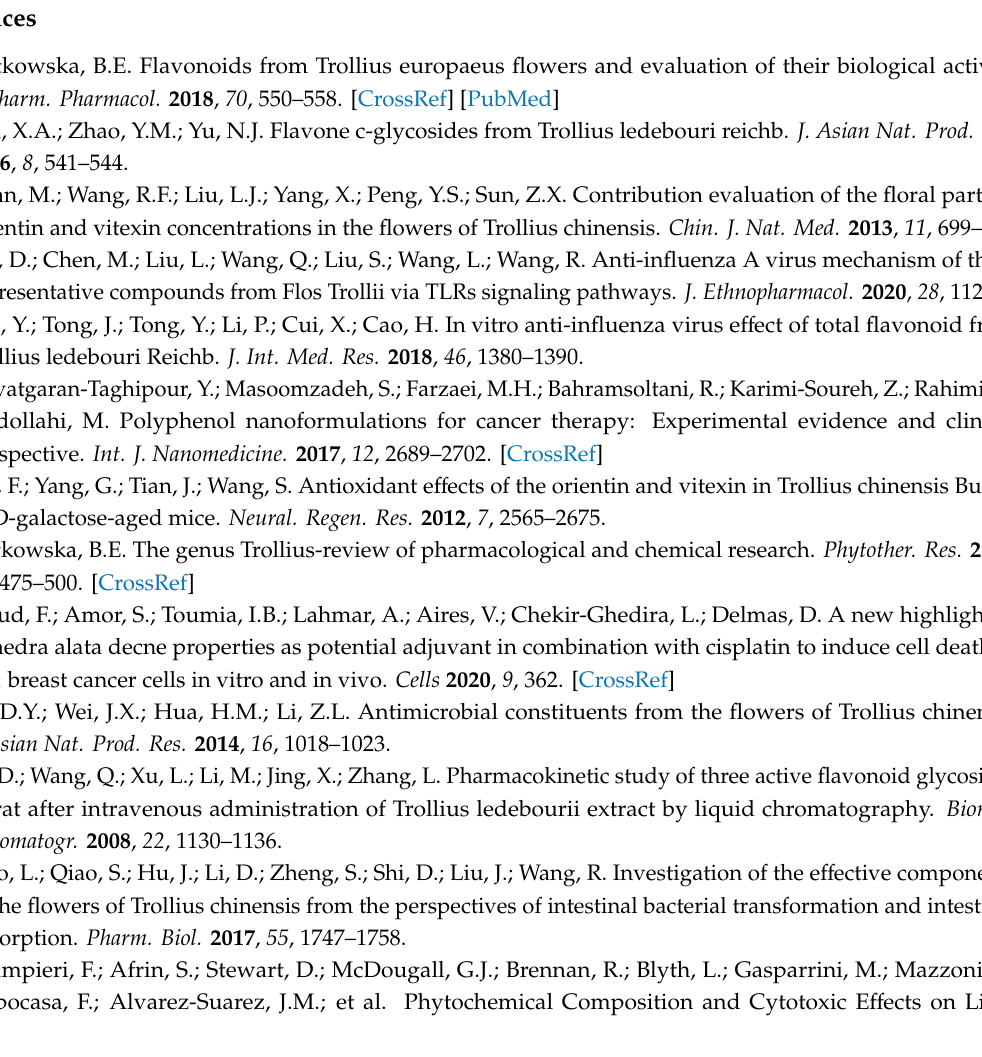
Figure S1. XICs of polyphenol reference compounds using di ff erent columns, Table S1. Standard references used for quantification, Table S2. MRM parameters used for method validation, Table S3. Summary of the method validation performance characteristics as determined in extracts from Chinese globeflower. Samples ( n = 5), Table S4. Absolute quantification results of T. chinensis and T. ledebouri by QqQ-MS. Samples ( n = 5), Table S5. Quantitative results of 154 polyphenols in T. chinensis and T. ledebouri